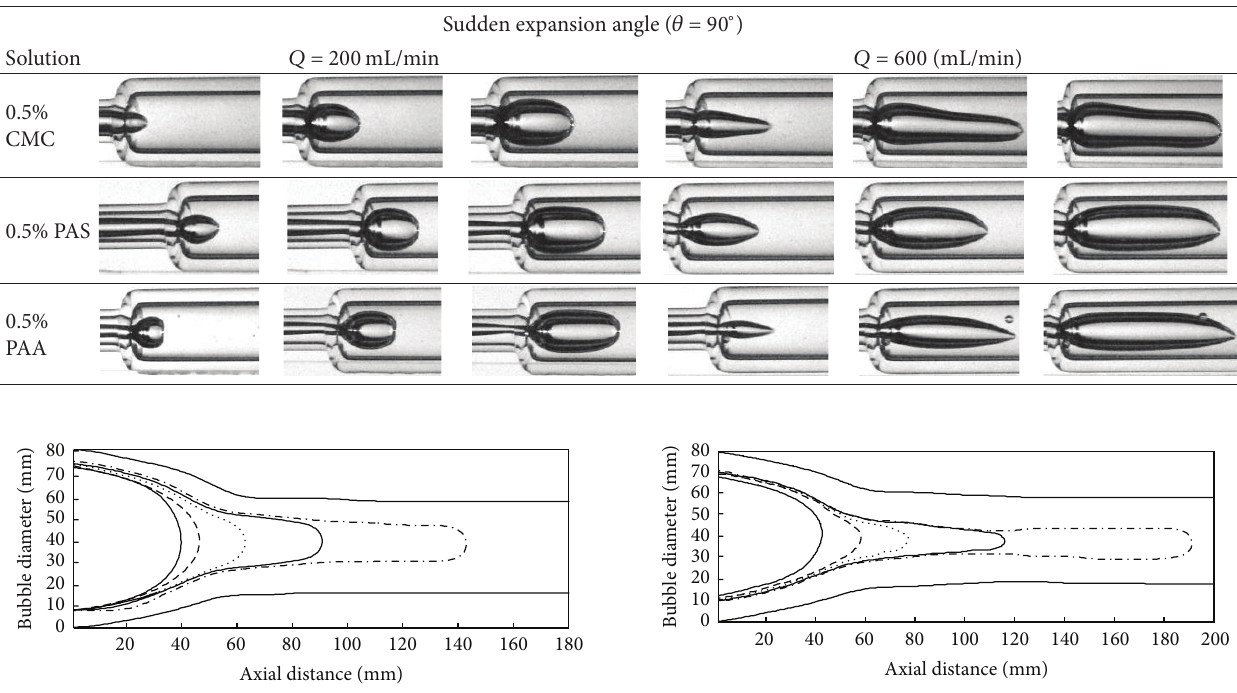
Figure 14: Bubble shape continuous variation in 0.5 wt% PAA for sudden contraction angle 𝜃 = 15 ∘ and 200 mL/min.